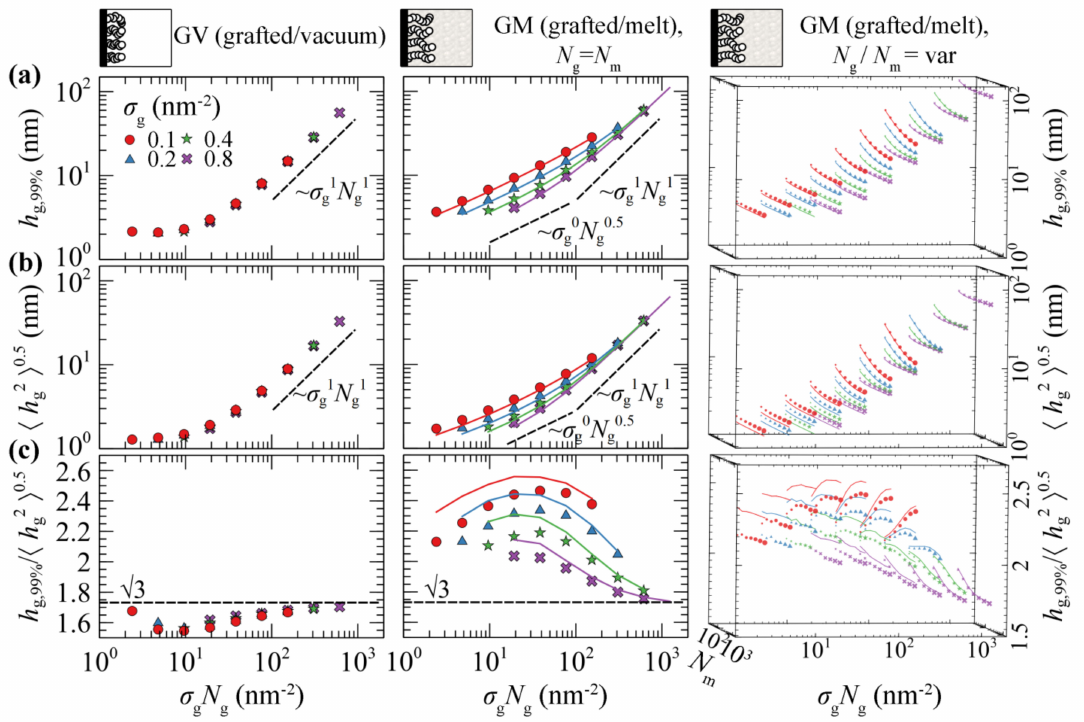
(cid:10) (cid:11) 0.5 (cid:10) (cid:11) 0.5 h g2 h g2 Figure 4. ( a ) h g,99% , ( b ) , and ( c ) their ratio h g,99% / versus the scaling law σ g N g using the SL-SGT (markers) and HFD (solid lines) EoS. The panels on the left column correspond to the GV system. The panels in the central row depict results regarding the GM system, for N g = N m . The rightmost column depicts results for the GM system as well, but with N m varying from 24 up to 1536 segments. Different colors and symbols denote different values of the surface grafting density; σ g = 0.1 (red/circles), 0.2 (blue/triangles), 0.4 (green/stars) and 0.8 (violet/crosses) nm –2 . The length of grafted chains increases implicitly in each panel from left to right, according to the scaling law expression presented in the labels of the x -axis. In the rightmost column the size of the symbols increases with the chain length of matrix chains. All cases have been evaluated in the absence of the ramp